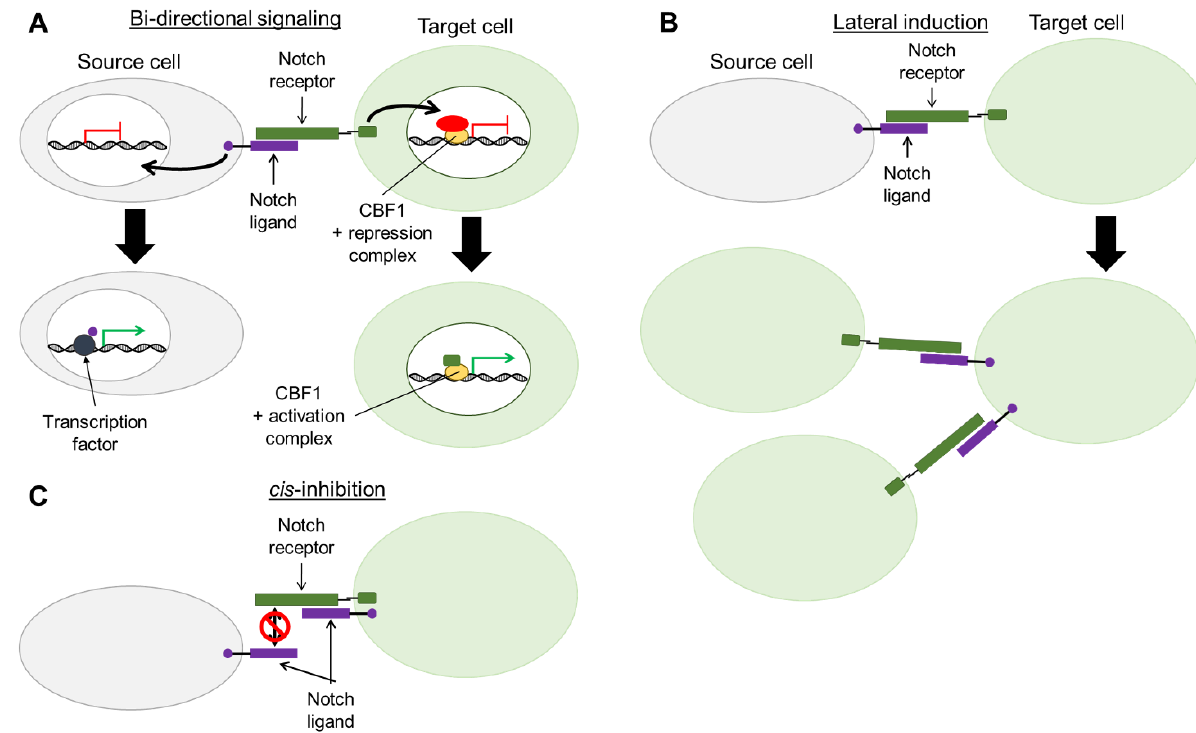
Figure 4. Mechanisms of Notch signaling regulation. ( A ) Following Notch activation, bi-directional Notch signaling can be initiated in both source and target cells. Cleavage of the intracellular domain of both Notch receptor and ligand can occur. These cleaved proteins translocate into the nucleus of their respective cells to function as transcription factors. ( B ) Notch activation in target cells can result in expression of Notch ligand. Such cells can subsequently function as source cells to activate Notch signaling in neighboring cells. This phenomenon is termed lateral induction. ( C ) Canonical Notch signaling can be blocked through cis-inhibition. This occurs when interaction of Notch receptor and ligand on the same target cell impedes the traditional trans-interaction of the ligand-expressing source cell with the target cell’s Notch receptor. CBF1: C- promoter binding factor 1 (also termed RBPjκ).